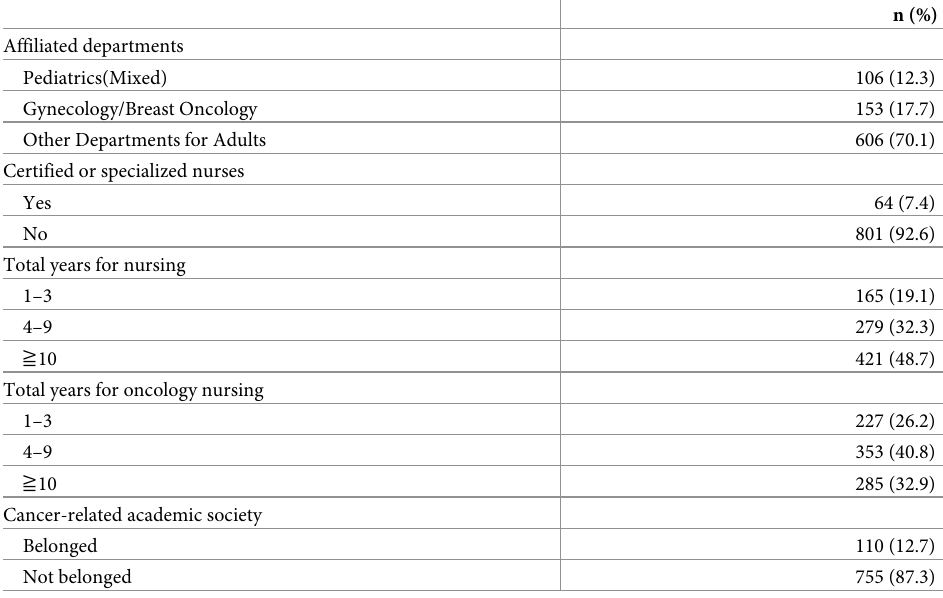
Table 1. Nurse’s background. n =